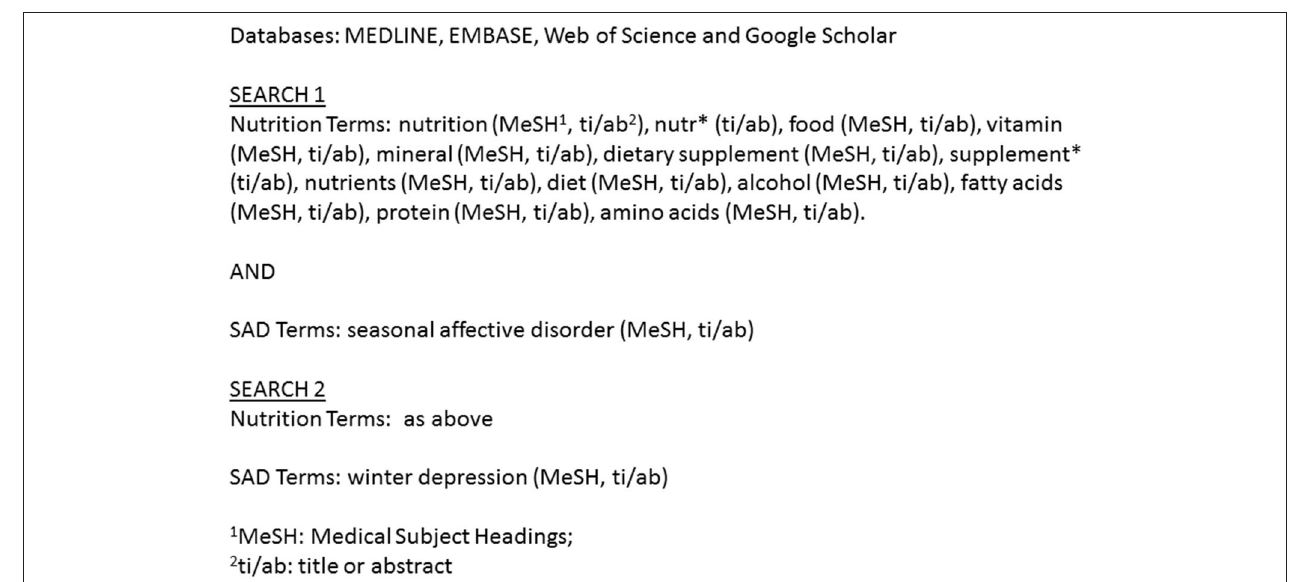
FIGURE 1 | Search